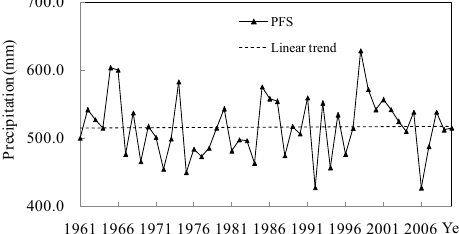
Fig. 4 Changes of PFS during 1961–2010 in the Jinsha River basin.